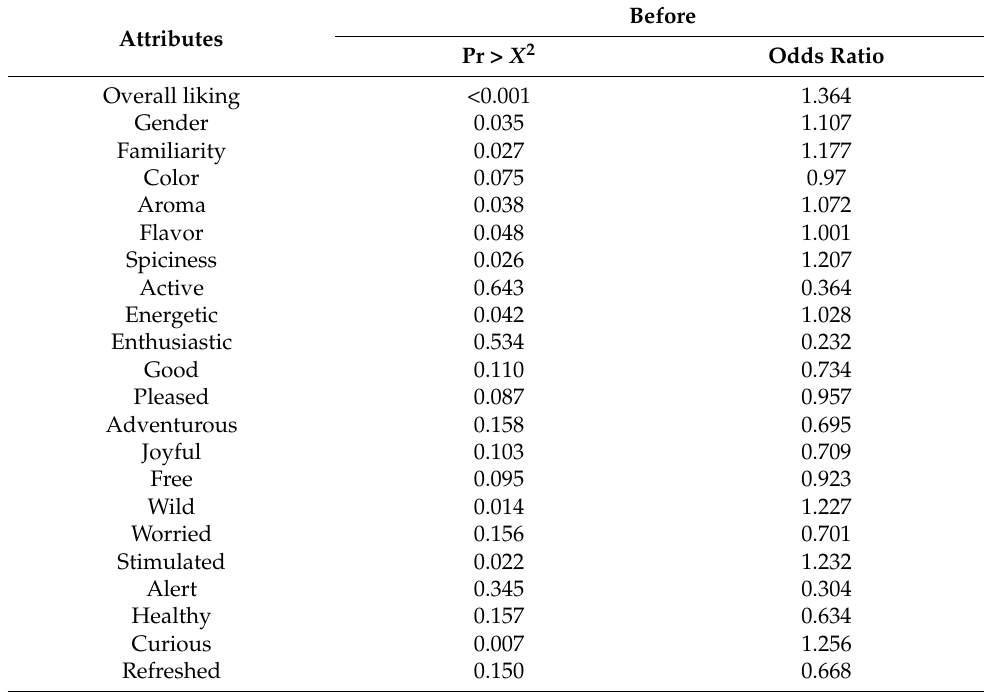
non-sensory factors of hot sauces formulated with vinegar (control), tequila, bourbon, vodka, and rum. Attributes